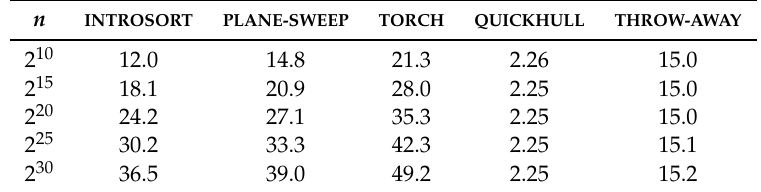
Table 9. The number of coordinate comparisons performed by the competitors [divided by n ] for the square data set.